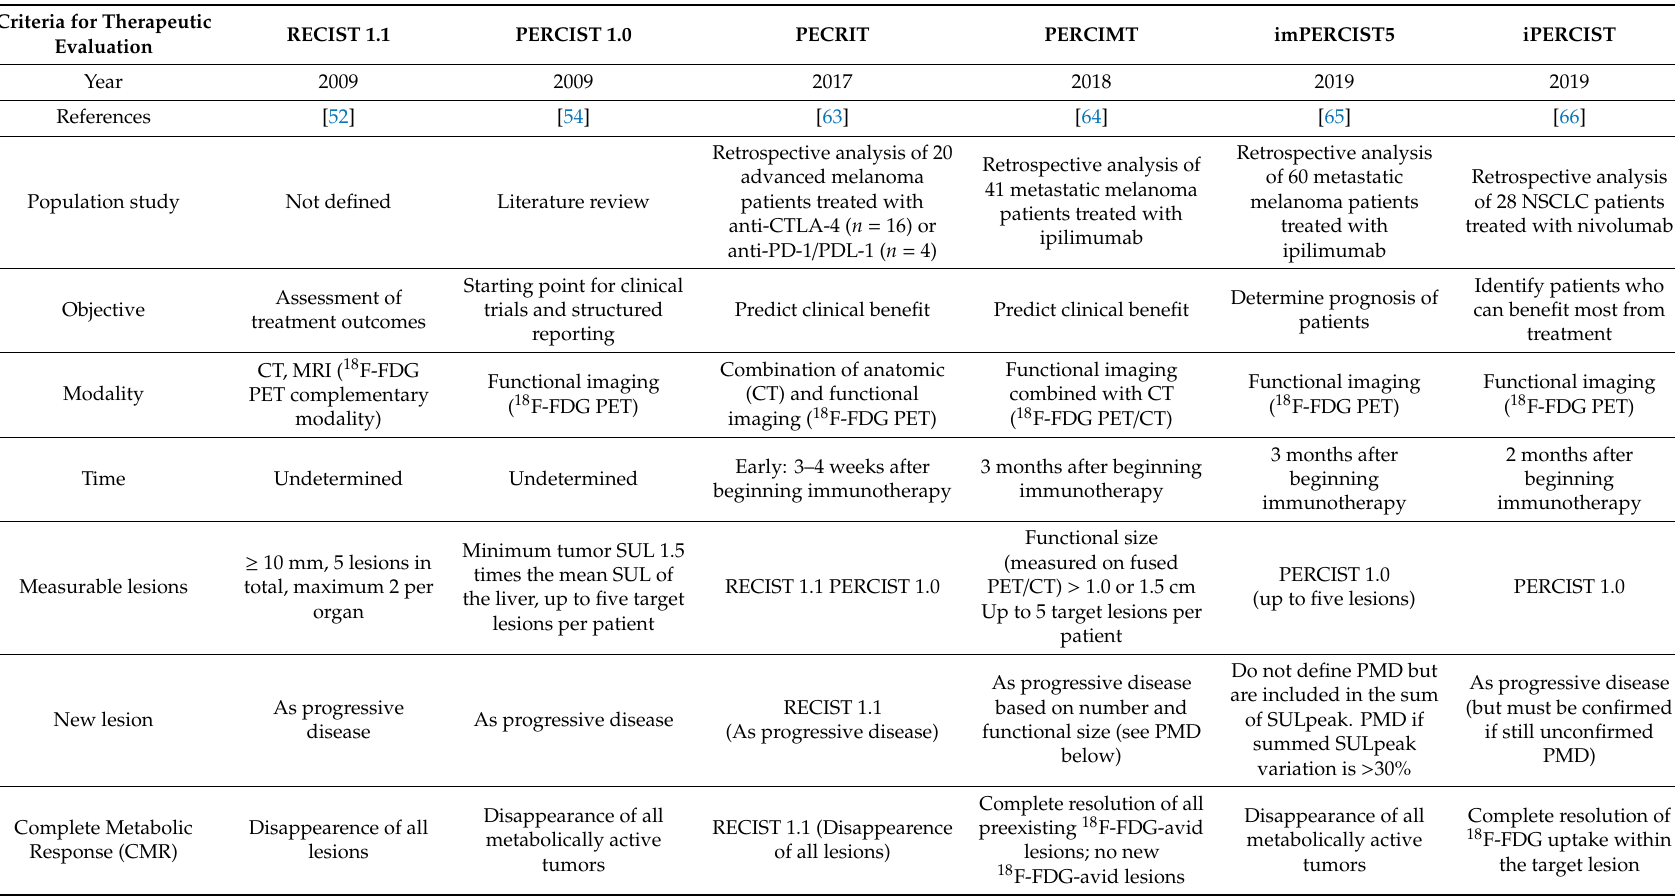
Table 2. Proposed criteria for therapeutic evaluation by 18 F-FDG PET / CT of solid tumors treated by immune checkpoint inhibitor. RECIST: Response Evaluation Criteria in Solid Tumors, PERCIST: PET Response Criteria in Solid Tumors, PECRIT: PET / CT Criteria for the early prediction of Response to Immune checkpoint inhibitor Therapy, PERCIMT: PET Response Evaluation Criteria for Immunotherapy; imPERCIST5: immunotherapy-modified PERCIST up to five lesions, iPERCIST: immune PERCIST, SUL: standardized uptake value normalized by lean body